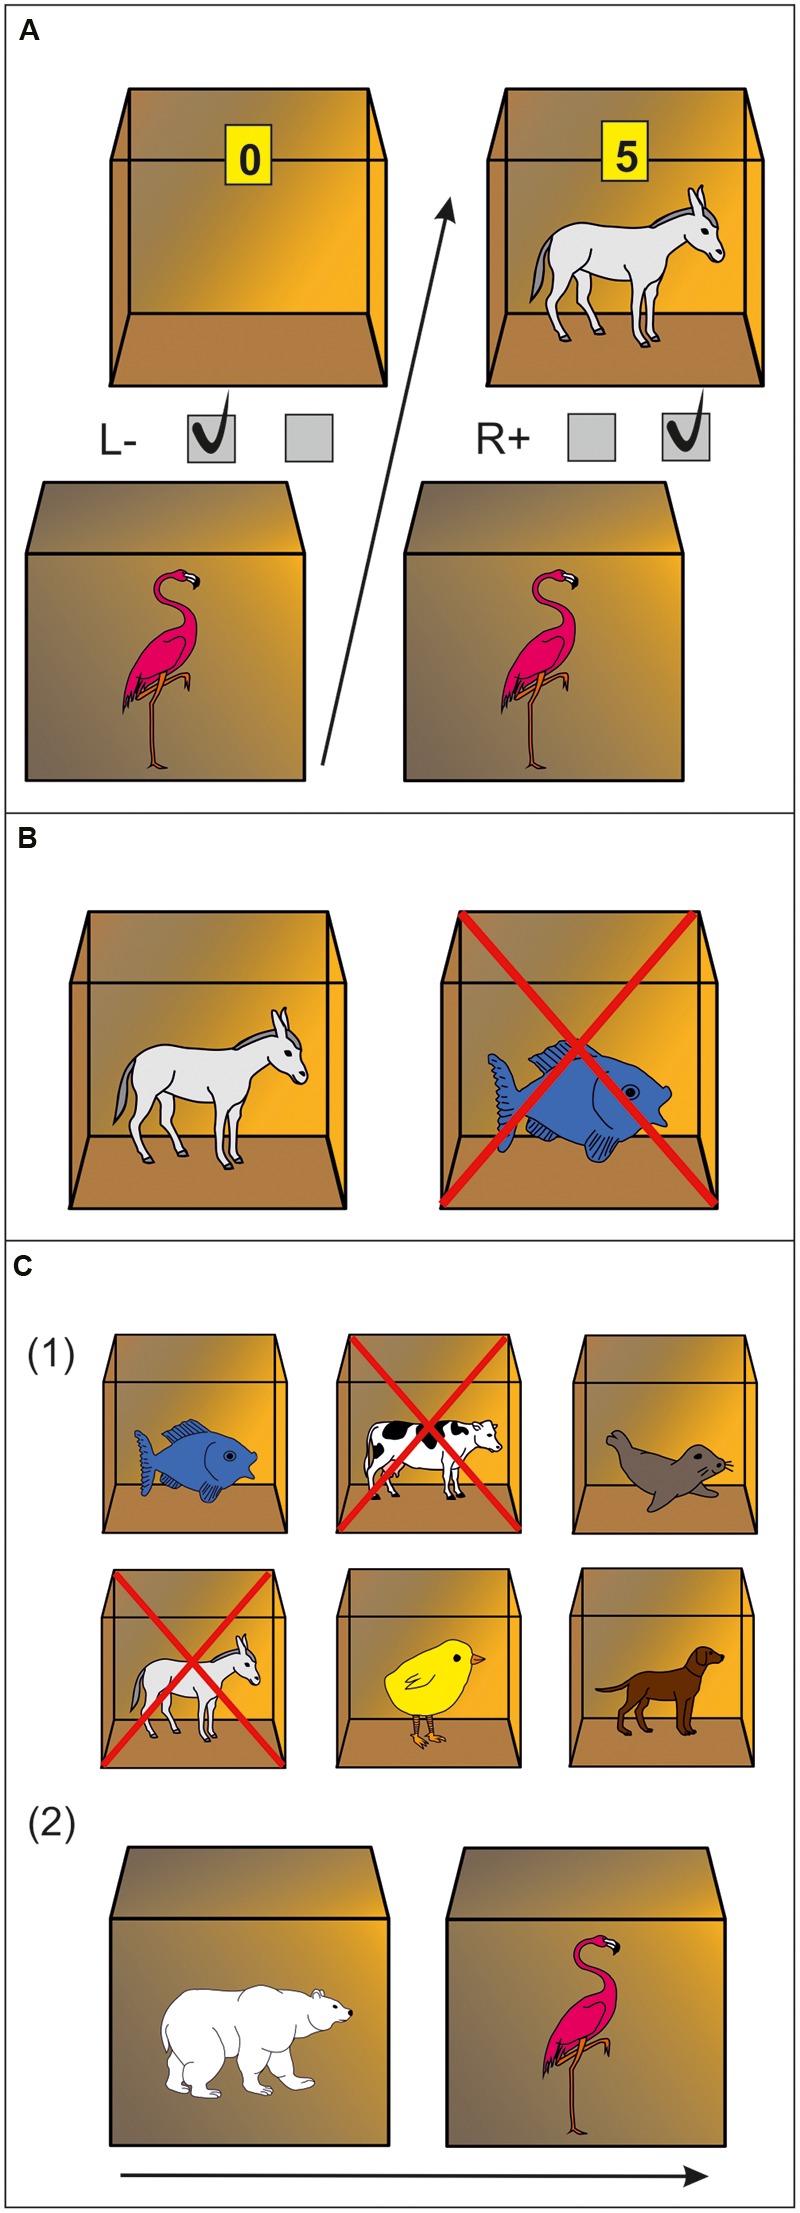
Experimental paradigm. (A) Discrimination training phase. In this example, a flamingo stimulus outside of a box indicates that pressing the right key will be rewarded with a donkey and points inside of the box. Pressing the left key will not be rewarded (empty box is revealed). (B) Outcome-devaluation test. In this example, two open boxes are presented with a donkey and fish inside. The cross superimposed on the fish signals this outcome is no longer worth any points. The accurate response in this example would be pressing the right key (which yielded the still-valuable donkey outcome during the training phase). (C) Slips-of-action test. (1) Participants are first presented with the six outcomes. In this example, donkey and cow are superimposed with a cross, indicating that the response leading to these outcomes will now result in subtraction of points (devaluation). The other animal outcomes are still valuable. (2) Afterwards, a rapid succession of animal stimuli are presented outside of boxes. Participants are instructed to press the correct keys if a stimulus indicates the availability of a still-valuable outcome inside the box (“Go,” example: polar bear stimulus signaling fish outcome), but withhold responding if the outcome inside the box has been devalued (“No-Go,” example: flamingo stimulus signaling donkey outcome).